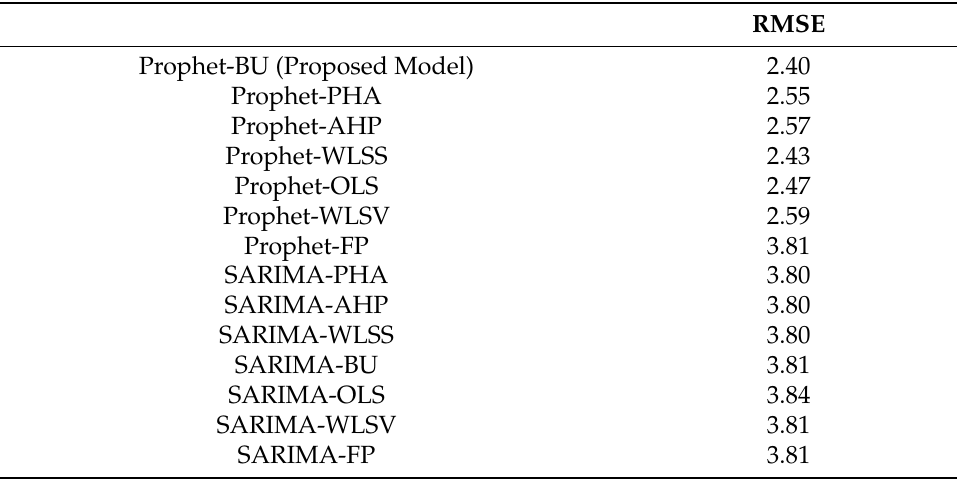
Figure 9. Forecast components (trend and seasonality) from Prophet-BU model for Middlesex county in MA. N.B: The top panel shows the forecast trend while the bottom panel shows the decomposed yearly seasonal pattern. Table 4. Performance comparison of proposed Prophet-BU hierarchical model (county level) with other Prophet and SARIMA hierarchical forecasting